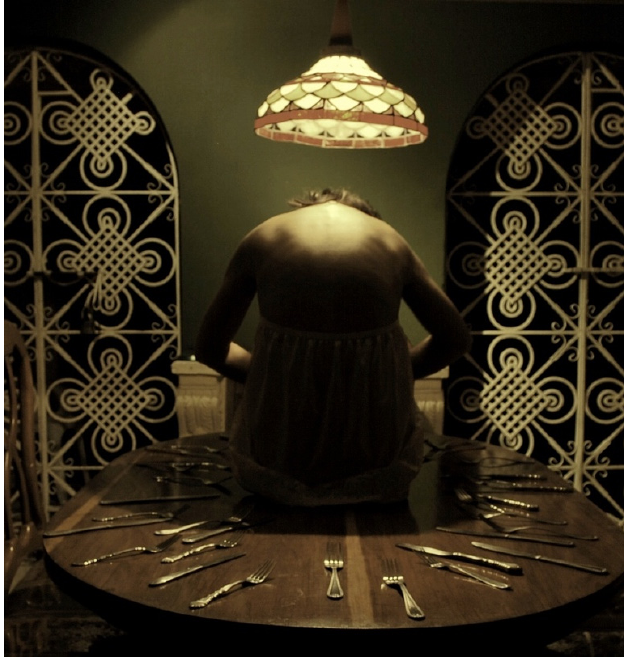
Figure 2. Raisa Galofre, Autoficciones (Series) , 2010. Image provided by the artist. Latin American feminists started questioning the tenets of second-wave feminism as it Galofre’s own image is fragmented into different roles across the Autoficciones . She was regarded in “advanced economies” and began a new trend of very diverse feminisms does not know how or why to assume femininity in order to feel integrated to her culture. that were intended to be inclusive of the divisions of class and race across the gender spectrum (De Giorgi 2018). Feminisms that became very strong in the political arena demanded attention to issues pertaining to very diverse populations whose situations were as different as the women themselves: displaced, black, indigenous, lower-class women, back to the “immanent realm” in order to question her place in